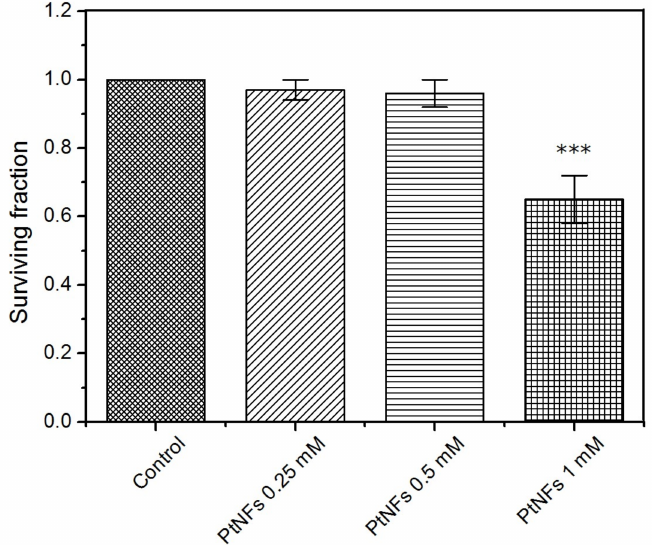
Figure 5. Cytotoxicity determined by clonogenic assay following a 6 h exposure to medium containing Pt NFs at di ff erent Pt concentrations of 2.5 × 10 − 4 , 5 × 10 − 4 and 10 − 3 mol L − 1 . Data represent the mean ± SD of three identical experiments made in triplicate. Asterisks denote significant di ff erences with control cells from ANOVA: *** p <